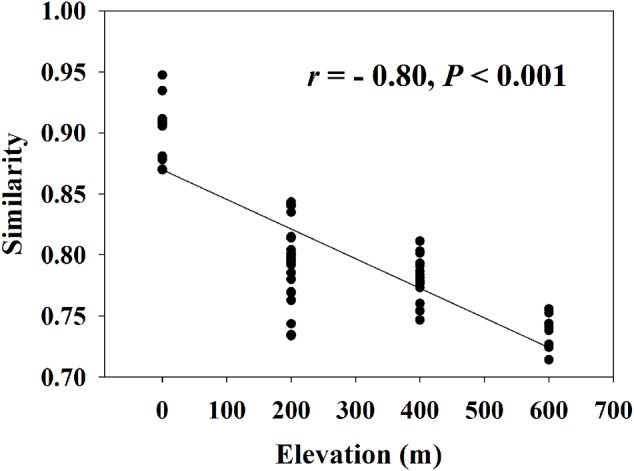
Elevation-decay relationship for whole microbial community (z-value = 0.0093, t = –209.6, n = 999, P < 0.001). Similarity represents Sorensen’s similarity index.